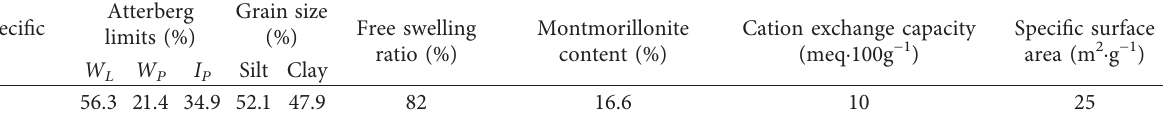
Table 1: Physical and index properties of Baise expansive soil.